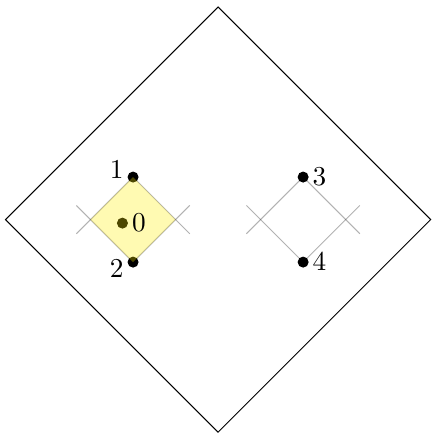
Figure 17. In the Lorentzian integral for a conformal block, the point x 0 is integrated over the diamond 2 < 0 < 1 (yellow). Because the integration region is far away from points 3 ; 4, the 3 (cid:2) 4 OPE is valid inside the